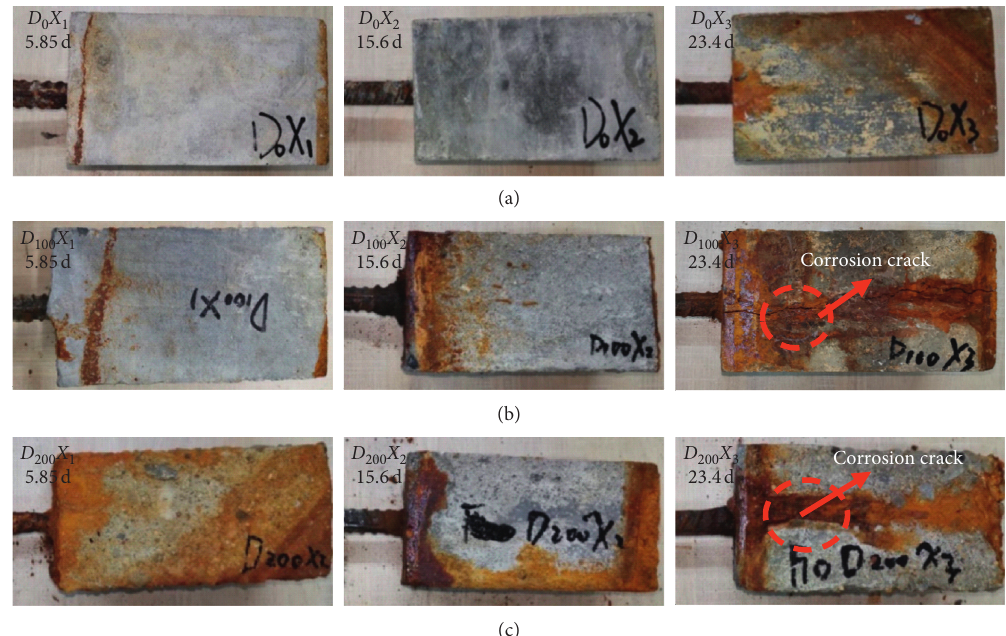
Figure 3: Surface changes of specimens under different freeze-thaw cycles. (a) 0 cycles of freeze-thaw. (b) 100 cycles of freeze-thaw. (c) 200 cycles of freeze-thaw.